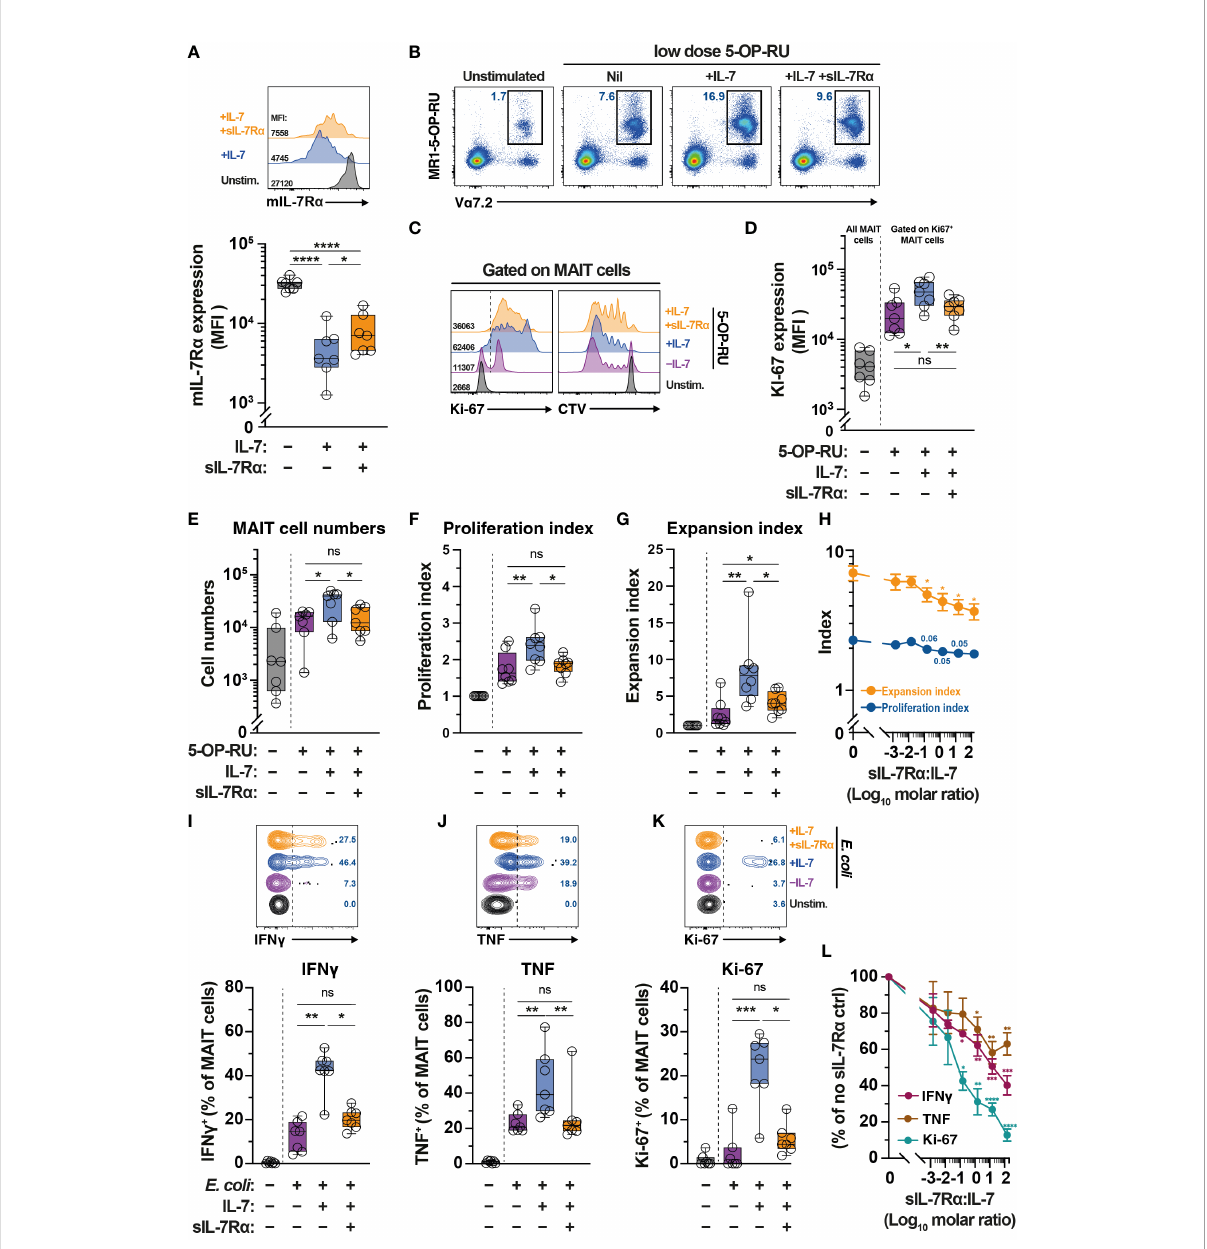
FIGURE 5 Soluble IL-7R a inhibits IL-7-mediated MAIT cell proliferation and effector function. (A) Expression levels of mIL-7R a on MR1-5-OP-RU tetramer + V a 7.2 + MAIT cells following 24 h treatment of PBMC with IL-7 alone or together with sIL-7R a (molar ratio 1:1) (N=7). (B – G) MR1-5-OP-RU tetramer + V a 7.2 + MAIT cell (B) proliferation as determined by Ki-67 expression levels on Ki-67 + MAIT cells (C ; left panel , D) , absolute MAIT cell numbers (E) , and proliferation (F) and expansion (G) indices calculated using CTV-dilution (C ; right panel ) following 5-days treatment of PBMC with 5-OP-RU, 5-OP-RU+IL-7, or 5-OP-RU+IL-7+sIL-7R a (sIL-7R a /IL-7molar ratio 1:1) (N=7-8). (H) Dose-dependent effect of sIL-7R a treatment on MAIT cells proliferation and expansion indices following 5-days treatment with IL-7- and 5-OP-RU (N=6-7). (I-K) MAIT cell expression of IFN g (I) , TNF (J) , and Ki-67 (K) after 24 h treatment of PBMC with IL-7 alone or together with sIL-7R a (molar ratio 1:1) followed by a further 24 h stimulation with formaldehyde- fi xed E coli (bacterial dose 0.1 CFU/cell) (N=7). (L) Dose-dependent effect of sIL-7R a treatment on MAIT cells cytokine and Ki-67 expression following treatment with E coli with or without IL-7 priming as in (I – K) (N=6-7). Expression levels for (L) were normalised to nil sIL-7R a controls to minimise inherent donor-to-donor variability, with statistical tests were performed on raw data. Box and whisker plots show all data points, median, and the interquartile range, whereas data presented as line graphs with error bars represent the mean and standard error. Statistical signi fi cance was determined using the Friedman test followed by Dunn ’ s post-hoc test (E, I, J, K) , or repeated measure one-way ANOVA with Tukey ’ s post-hoc test (A, D, F,G) , or mixed-effect analysis with Dunnett ’ s post-hoc test (H, L) . **** p<0.0001, *** p<0.001, ** p<0.01, * p<0.05, ns, not signi fi